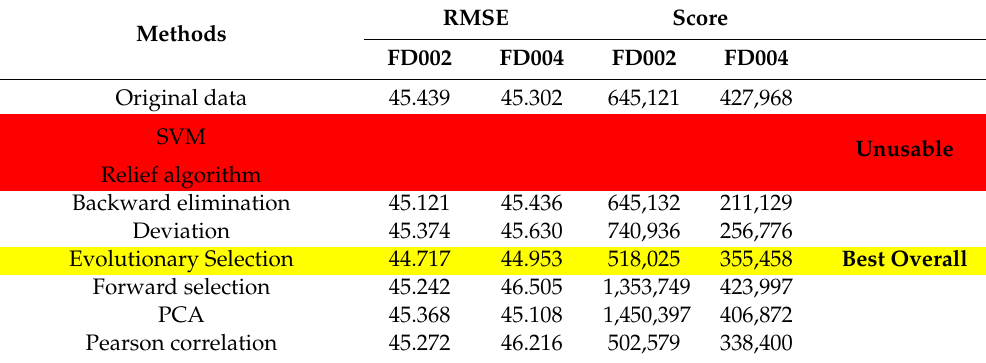
Table 4. Best root mean square error (RMSE) and Prediction Score results of RUL prediction from all DNN